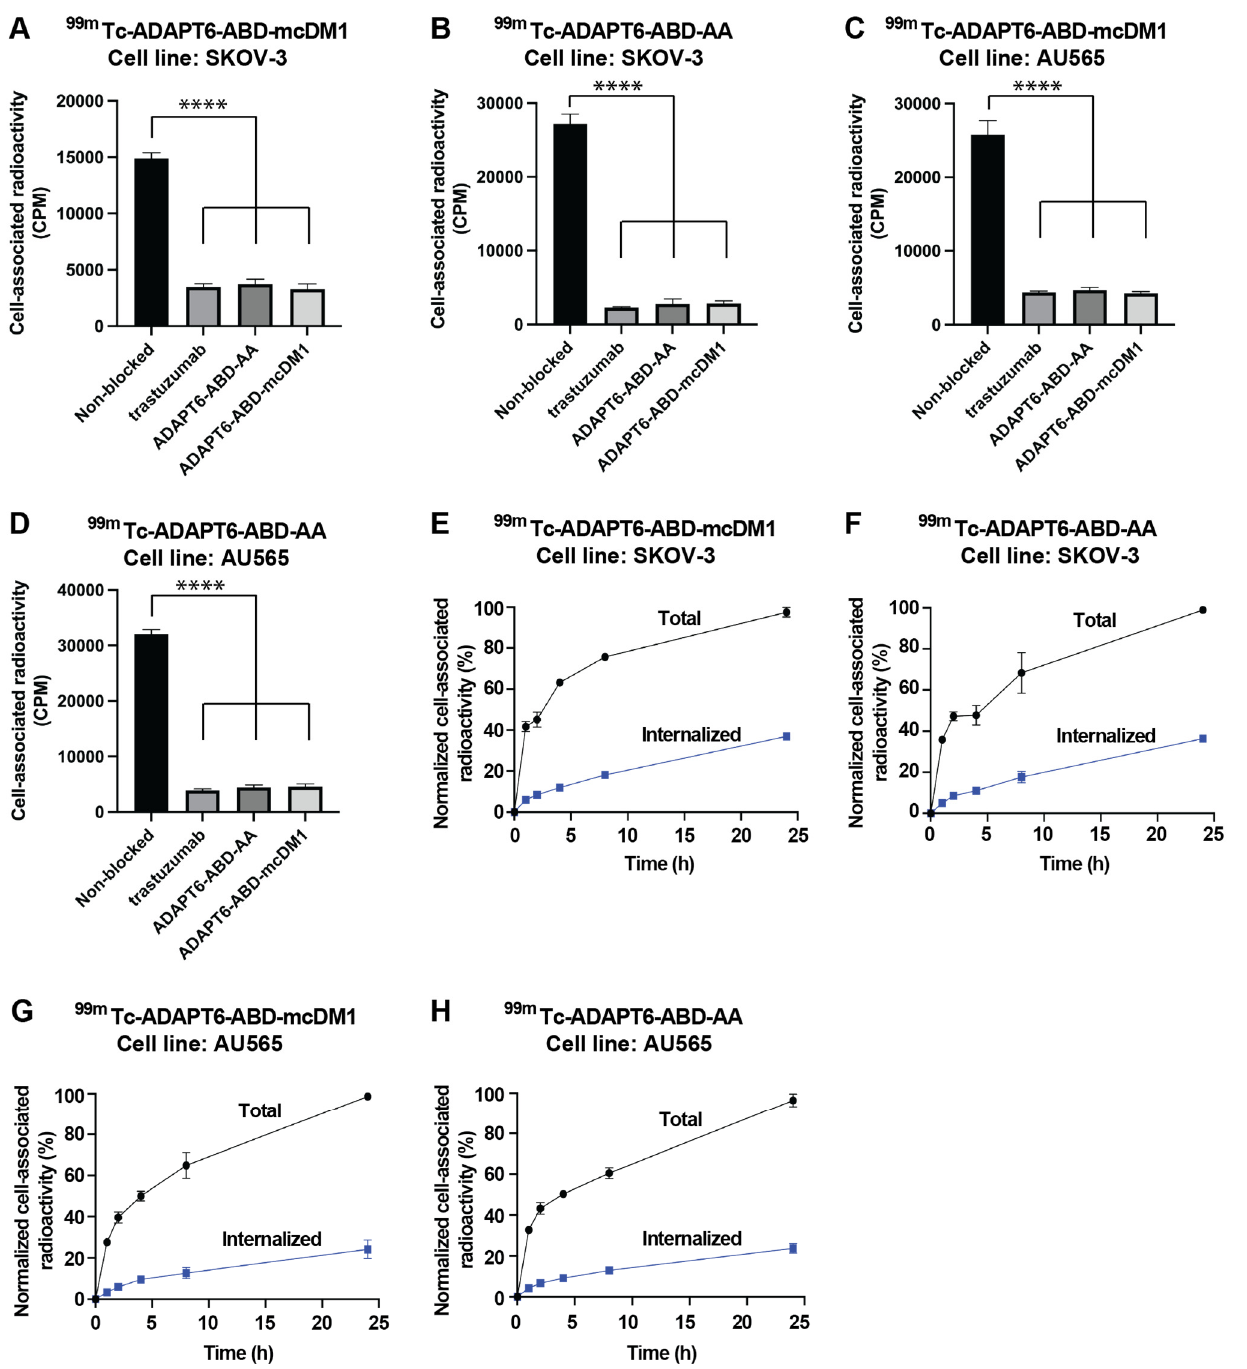
Figure 4. Binding specificity and cellular processing of 99m Tc-labeled ADAPT6 constructs. ( A – D ) SKOV-3 or AU565 cells were incubated with 99m Tc-ADAPT6-ABD-mcDM1 or 99m Tc-ADAPT6-ABD-AA, indicated above each panel. For pre-saturation of HER2 receptors, a 100-fold molar excess of non-radiolabeled trastuzumab, ADAPT6-ABD-AA or ADAPT6-ABD-mcDM1 was added to the cells. The data are mean values of radioactivity measured in three cell dishes ± 1 SD. ( E – H ) Cellular processing of ADAPT6-ABD-AA and ADAPT6-ABD-mcDM1 by SKOV-3 and AU565 cells during 24 h. The constructs and cell lines are indicated above each panel. The data were normalized to the average of maximum cell associated radioactivity for each radioconjugate, which was set to 100%. The data are mean values of radioactivity measured in three cell dishes ± 1 SD. The significance indicator **** correspond to p < 0.0001.